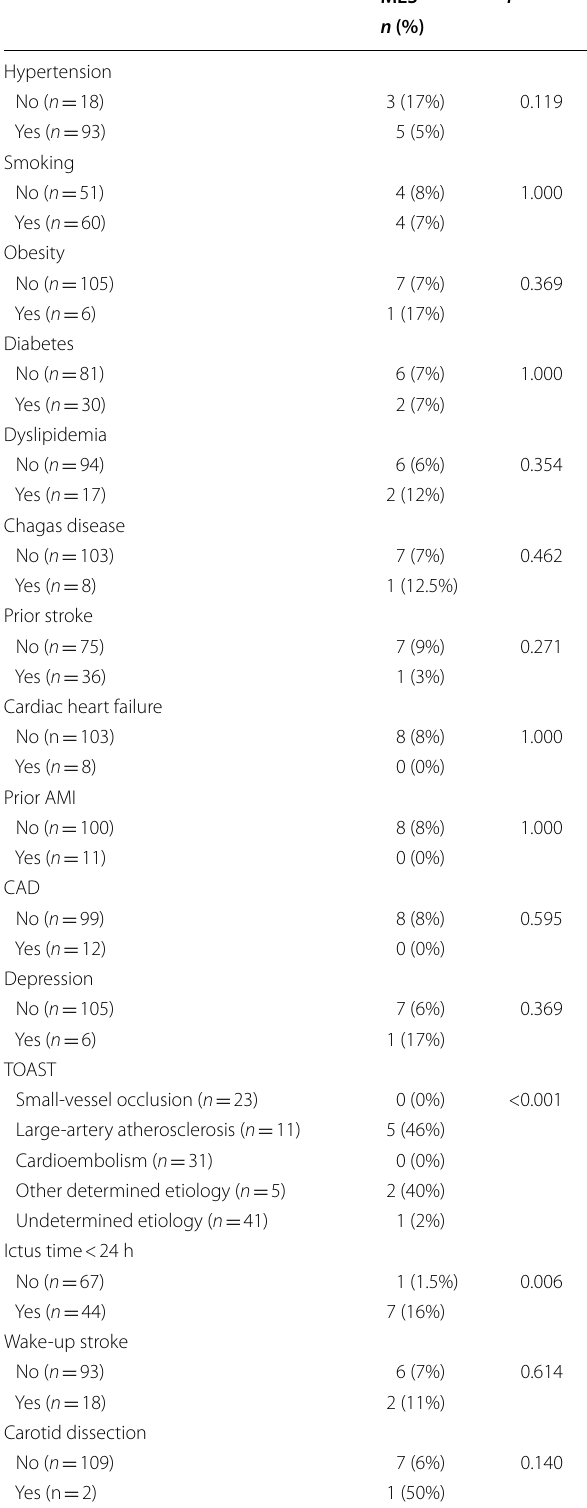
Table 2 Relationship between risk factors, etiology, and clinical presentation with MES